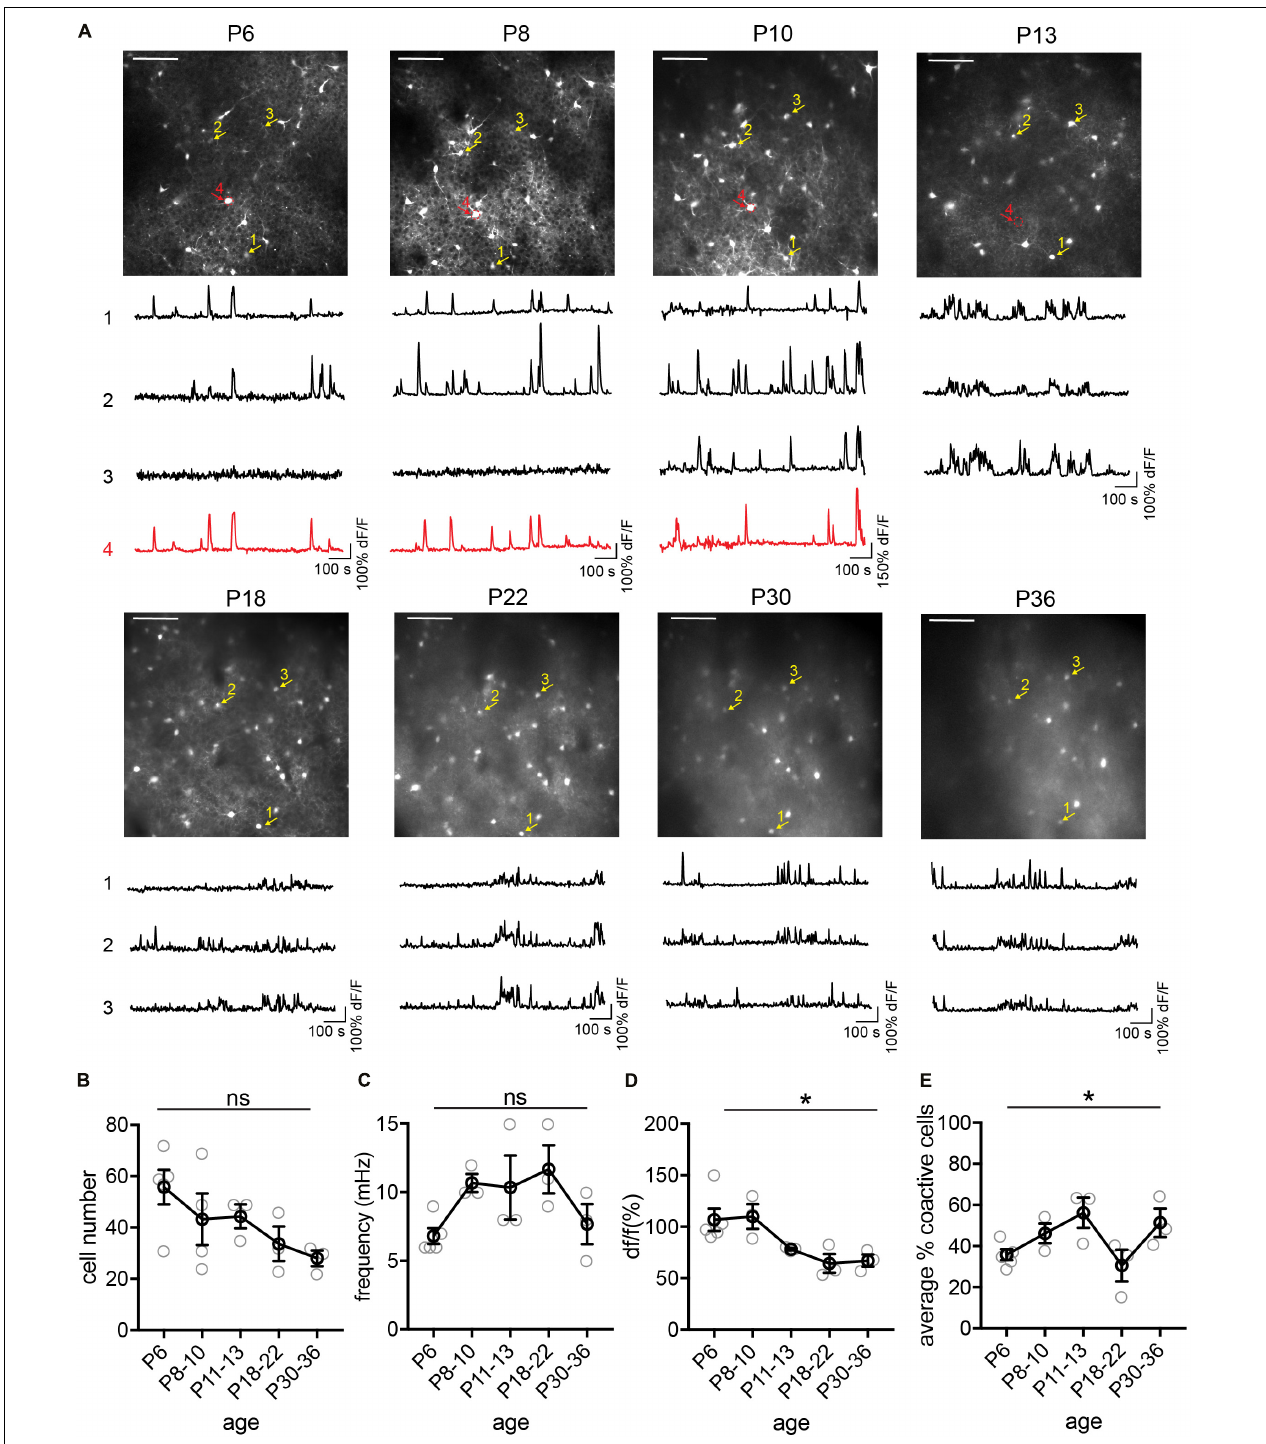
FIGURE 4 | Longitudinal imaging of SST interneurons. (A) The same two-photon FOV from a SST.GCaMP6s mouse at P6, P8, P10, P13, P18, P22, P30, and P36. Scale = 100 µ n. The same example cells across different ages are indicated by numbered arrows. The yellow ones survived from P6 to P30, while the red one died between P10 and P13. Corresponding raw (cid:49) F/F traces are shown below each FOV. (B) Quantification of the number of active cells in a FOV at P6, P8–10, P18–22, and P30–36. Kruskal–Wallis test, p = 0.12. n = 5 FOVs for P6, 4 FOVs for P8–10, 3 FOVs for P11–13, P18–22, and P30–36, from two longitudinally imaged animals. (C) Quantification of the average event frequency for each cell, p = 0.07. (D) Quantification of the average event amplitude for each cell. * p = 0.014. (E) Quantification of the average percentage of coactive cells. * p = 0.041. Black circles indicate mean from all videos; gray circles indicate individual videos; error bars indicate